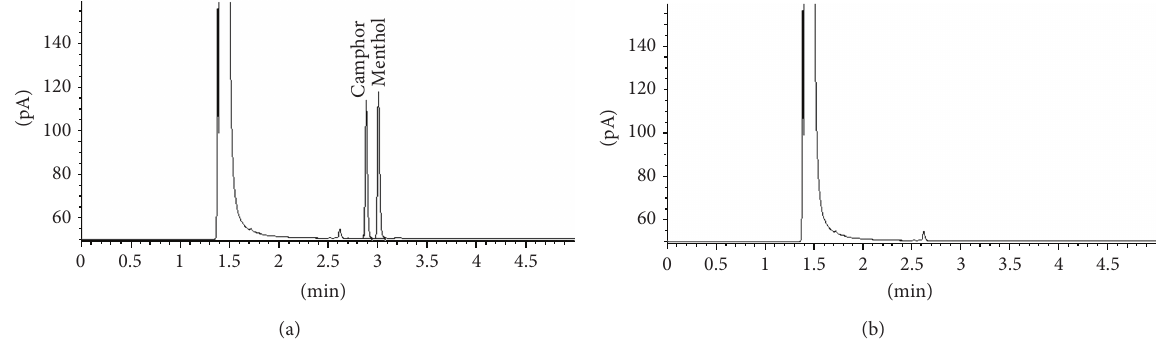
g/mL), excipients sample working solution (including camphor 𝜇𝜇